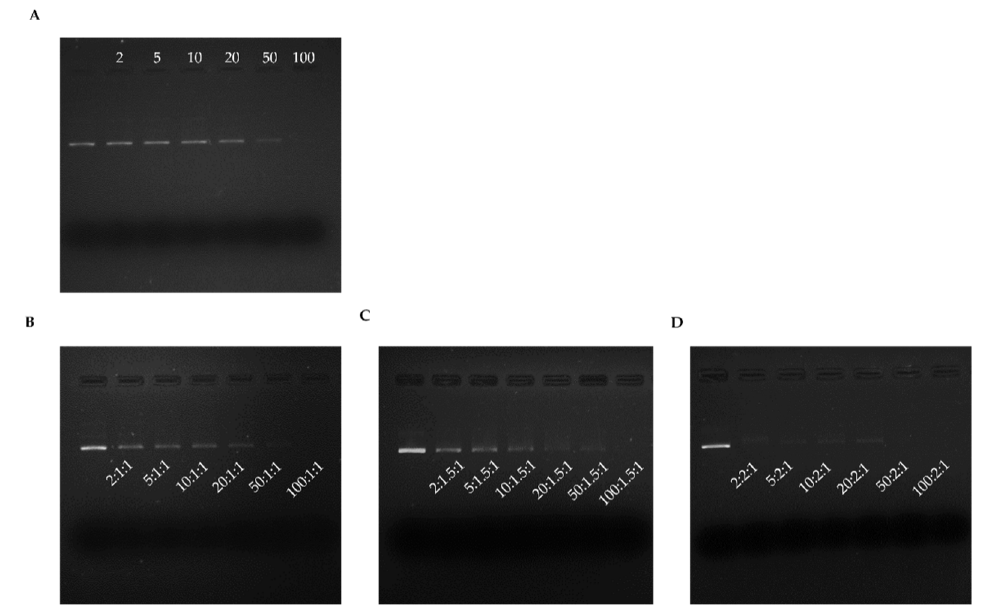
Figure 2. The pDNA complexation capacity of PAMAM G4-PTX/pDNA ( A ) at N/P ratios of 2, 5, 10, 20, 50, 100; PAMAM G4-PTX/pDNA/PEI ( B ) at N/P ratios of 2:1:1, 5:1:1, 10:1:1, 20:1:1, 50:1:1, 100:1:1; PAMAM G4-PTX/pDNA/PEI ( C ) at N/P ratios of 2:1.5:1, 5:1.5:1, 10:1.5:1, 20:1.5:1, 50:1.5:1, 100:1.5:1; PAMAM G4-PTX/pDNA/PEI ( D ) at N/P ratios of 2:2:1, 5:2:1, 10:2:1, 20:2:1, 50:2:1, 100:2:1 investigated by agarose gel electrophoresis. The samples were loaded at the application site at the upper end of the image and the lower end is the cathodic end. Lane 1: pDNA control.